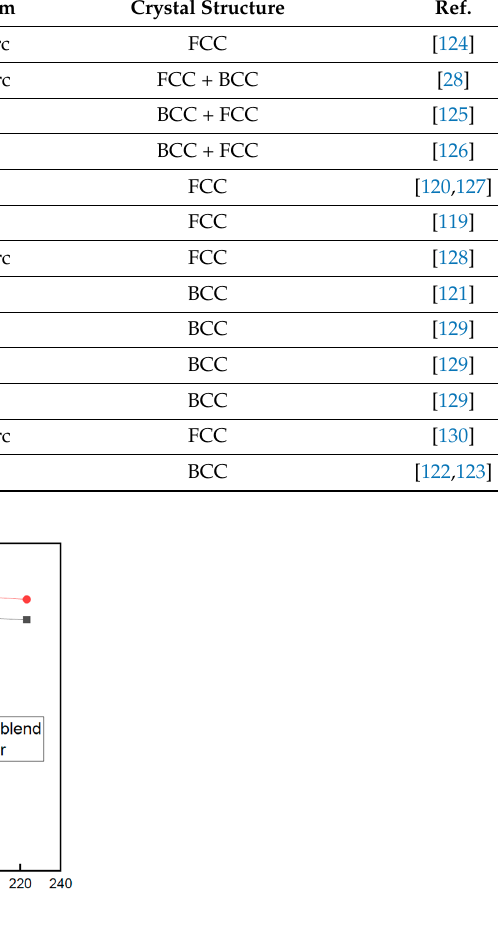
Figure 8. Density of CrFeCoNi HEA using both mix elemental and pre-alloyed powders vs. different volume laser energy by Hou et al. [120].